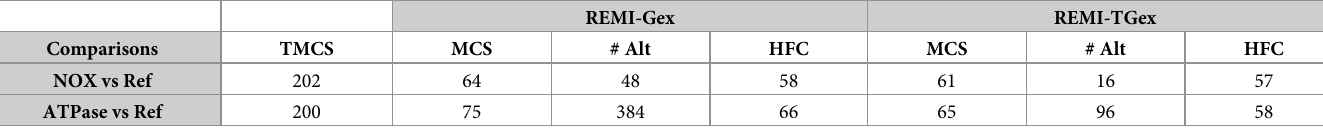
Table 2. Maximum consistency score and alternatives for REMI-Gex and REMI-TGex in the second E. coli study. “Ref” represents the wildtype, and ATPase overex- pression and NOX overexpression are relative to the wildtype. TMCS, theoretical maximum consistency score; MCS, maximum consistency score; # Alt, number of alter- natives; HFC, high frequency constraint.